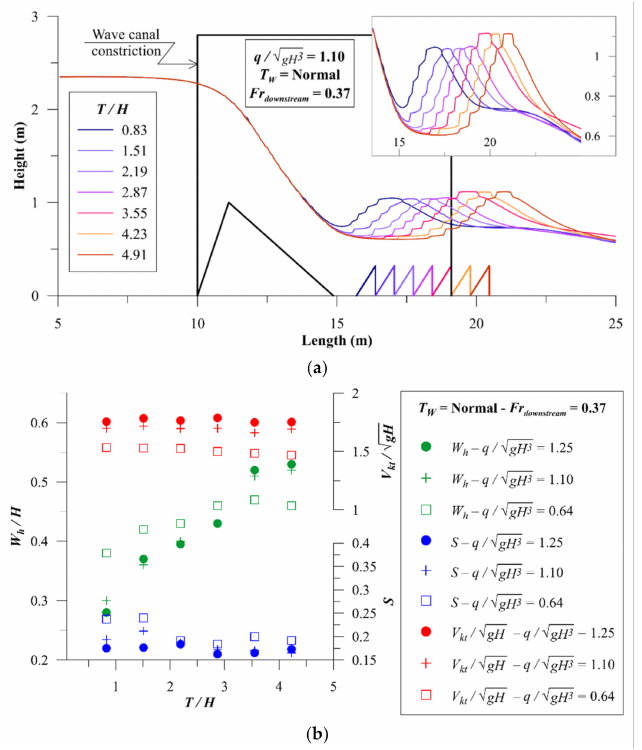
Figure 7. Effect of the transition length on the surf wave: ( a ) required transition for complete development of the trough, ( b ) sensitivity of the surf wave to transition